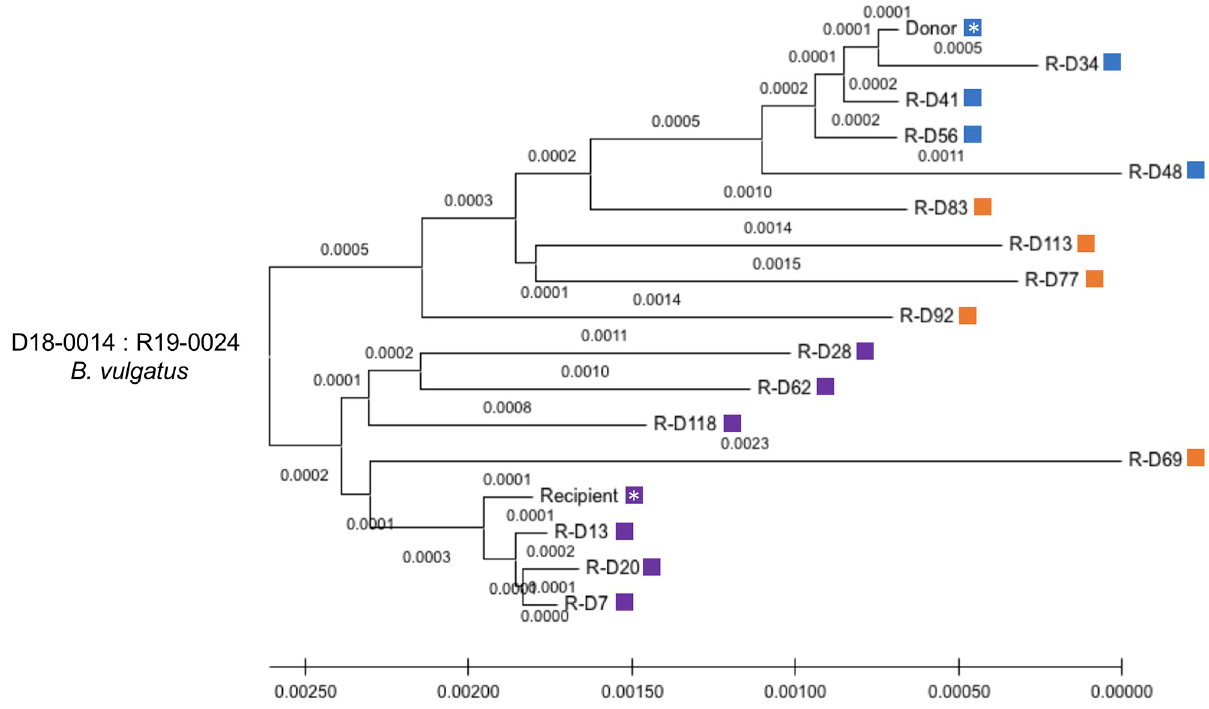
Fig 4. StrainPhlAn analysis for B . vulgatus on donor 18–0014 and recipient 19–0024 pair. StrainPhlAn analysis on FMT donor 18–0014 and recipient 19–0024 pair was done for B . vulgatus across all samples in this pair. A neighbor-joining (NJ) tree was constructed and the tree is drawn to scale with branch lengths. Then, the same steps described in the legend of Fig 3 were applied to complete constructing the tree using MEGA X. The blue and purple color boxes shown next to the NJ tree match the color boxes shown in Fig 2A and the orange color boxes show a recombinant strain which is displayed as both numerical numbers in Fig 2A. A white asterisk indicates a donor and recipient pre FMT sample.